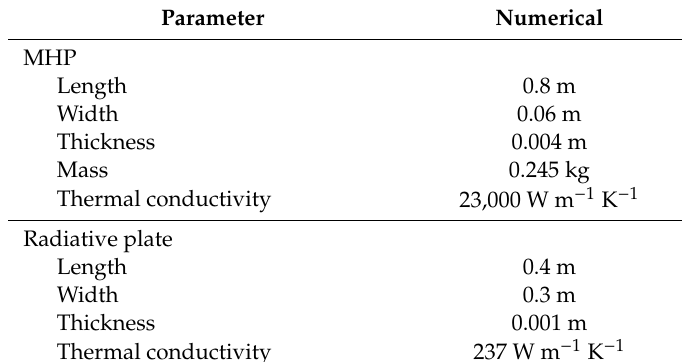
Table 1. The material parameters of the testing rig.